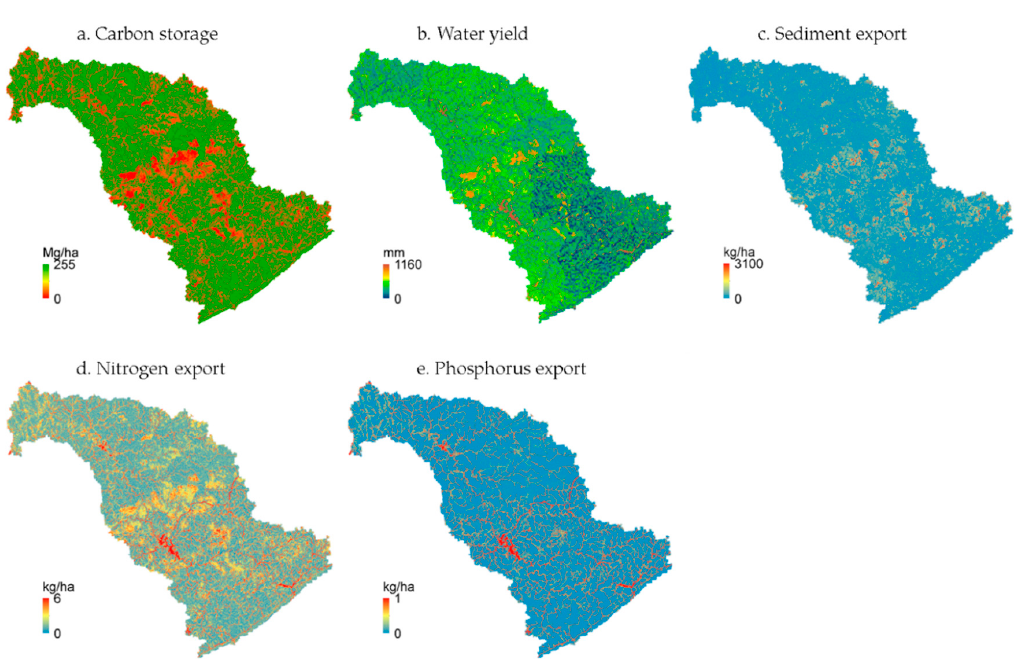
Figure 3. Spatial distribution of modeled ( a ) carbon storage (mg per ha), ( b ) water yield (mm), ( c ) sediment export (kg per ha), ( d ) nitrogen export (kg per ha), and ( e ) phosphorus export (kg per ha) across the NFKR Watershed under the 2011 LULC conditions.